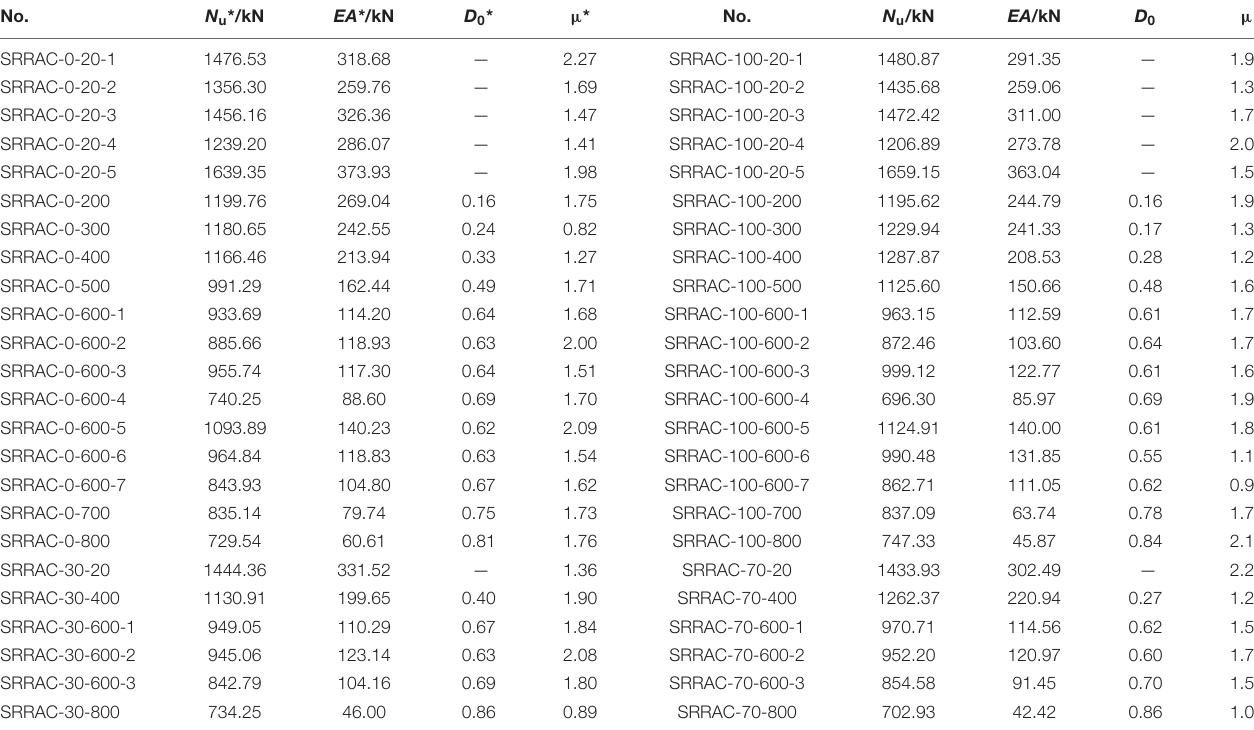
TABLE 5 | Mechanical performance index of